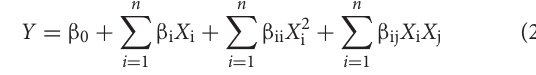
steps of traditional HD extraction in this study, the TCEO was obtained and stored at − 18 ◦ C for further